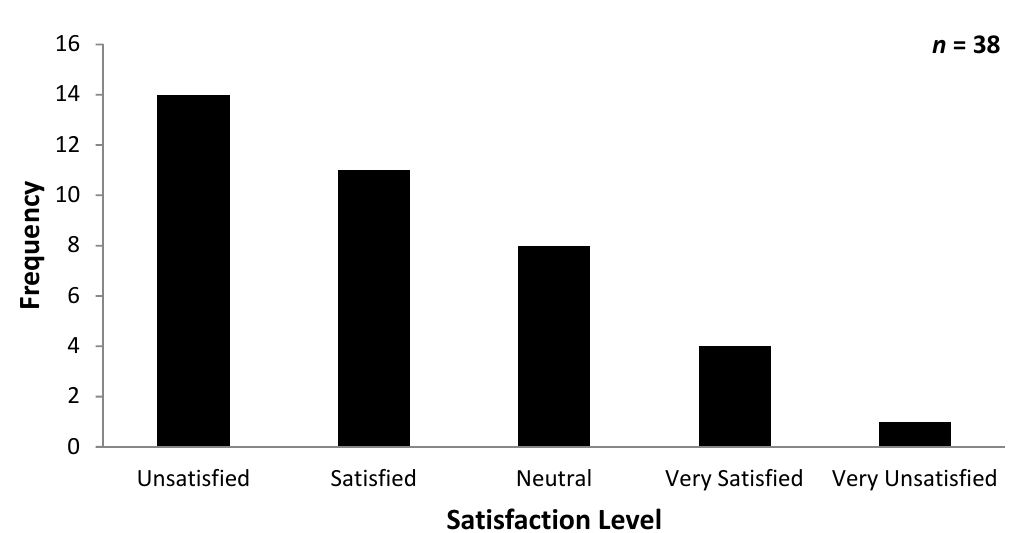
Figure 6. Recreational swordfish anglers’ perceptions of current federal swordfish regulations.